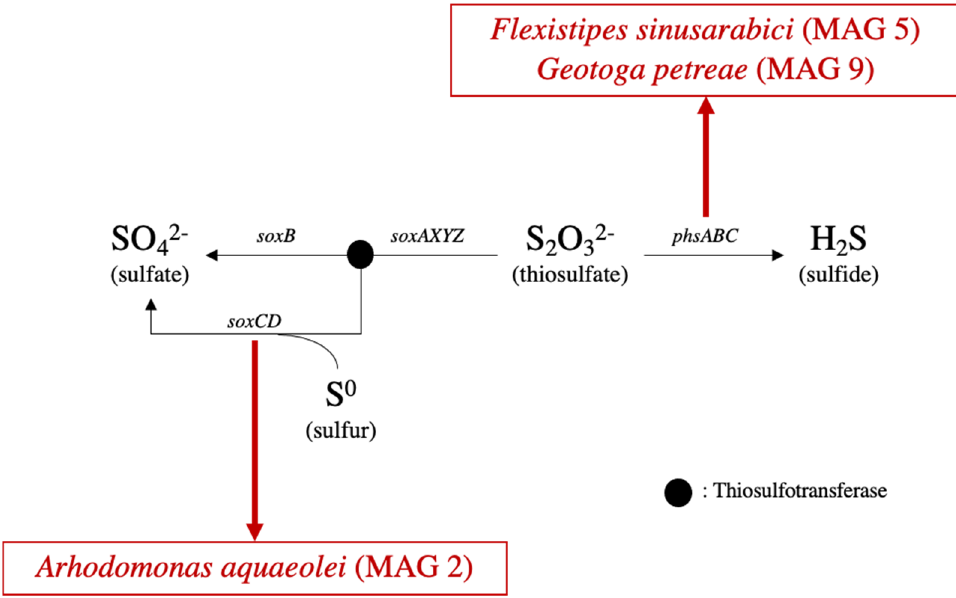
Figure 2. Genes present within MAGs for thiosulfate oxidation (SOX system— left branch ) and thiosulfate reduction ( right branch ).